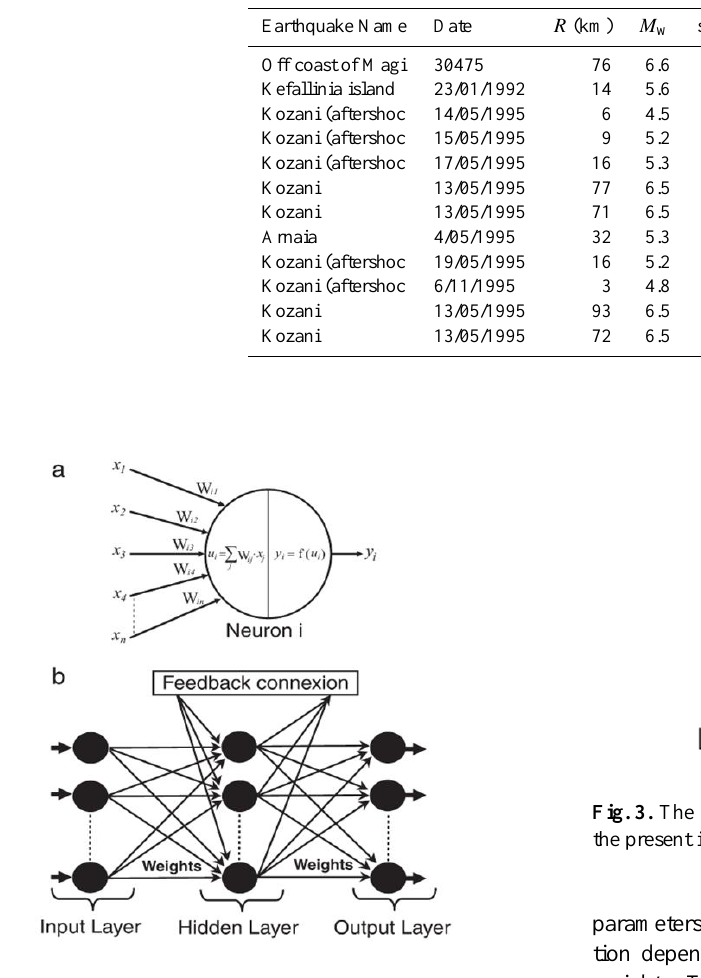
Fig. 2. General topology of a feed-forward ANN with one hidden layer.